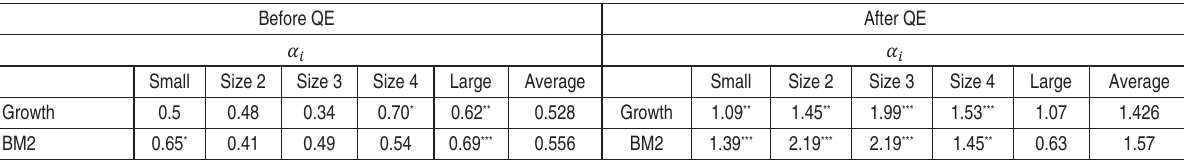
Table 5. The impact of structural monetary policy shocks on the ERP of the 25 value-weighted Fama-French portfolios: pre and post quantitative